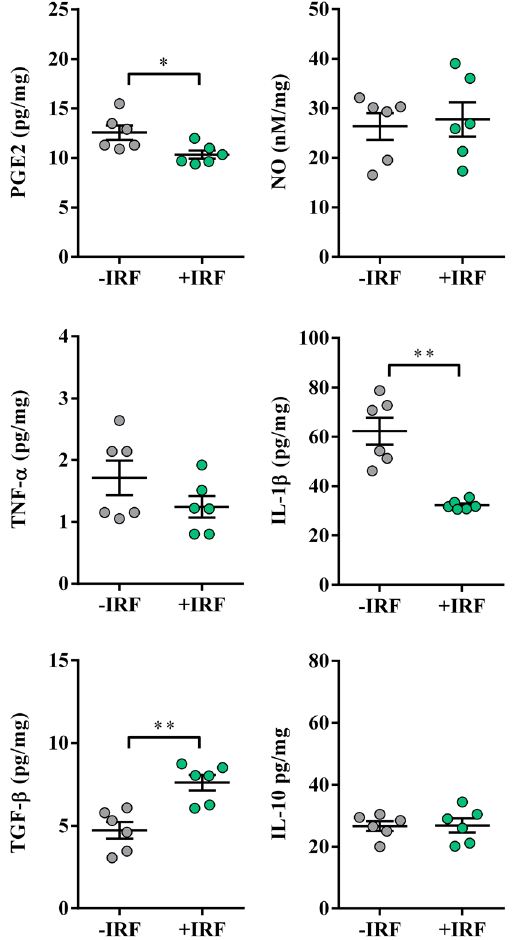
Figure 9. Influence of exposure to IR fibre bedding on the production of PGE2, NO, and cytokines by carrageenan-inflamed paws. Scatter plots (created using GraphPad Prism version 7.00 for Windows, GraphPad Software, La Jolla California USA; https ://www.graph pad.com) show PGE2, NO, TNF-α, IL-1β, TGF-β and IL-10 production levels in the supernatants from 4 h (PGE2) or overnight right carrageenan-inflamed hind paw tissue cultures (normalized to the paw weight) (see Material and Methods) from rats housed in cages with IR fibre bedding (+IRF) and with standard wooden shaving bedding (−IRF rats). Results are expressed as mean ± SEM. n = 6 rats/group. * p ≤ 0.05 and ** p ≤